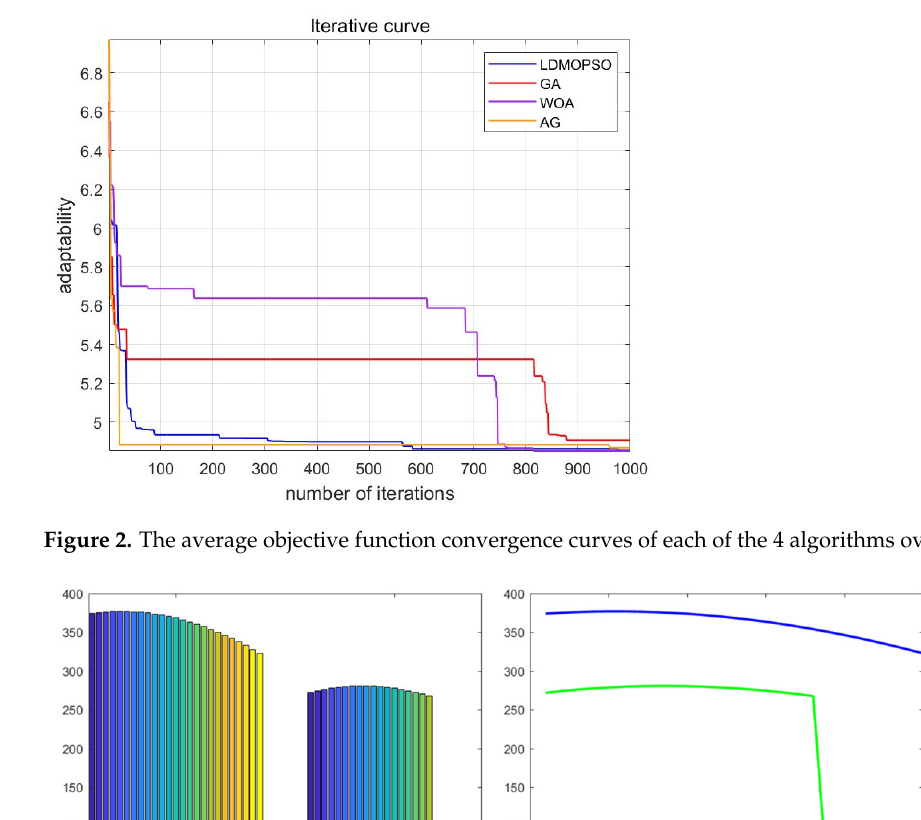
Figure 3. Water level change curves of two reservoirs.